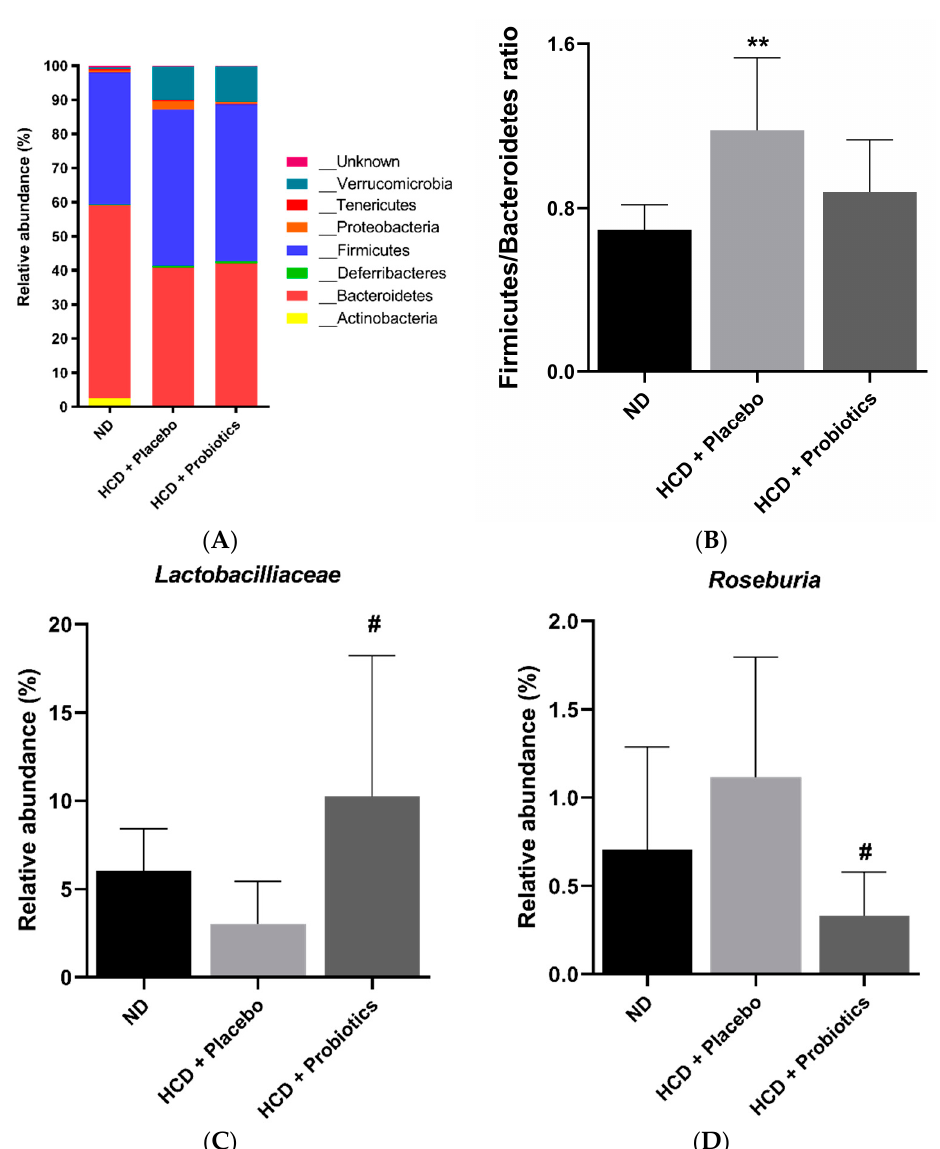
Figure 7. Effects of MSPs on the gut microbiota. ( A ) Bar chart of relative abundances of bacteria at the phylum level. ( B ) The Firmicutes/Bacteroidetes ratio of intestinal microbiome in mice. ( C ) Relative abundance of Lactobacilliaceae family members. ( D ) Relative abundance of the Roseburia genus. Data are expressed as mean ± standard deviation ( n = 6–7 per group). ** p < 0.01 vs. ND, # p < 0.05 vs. HCD + placebo. Legend: HCD, high-carbohydrate diet; ND, normal diet.